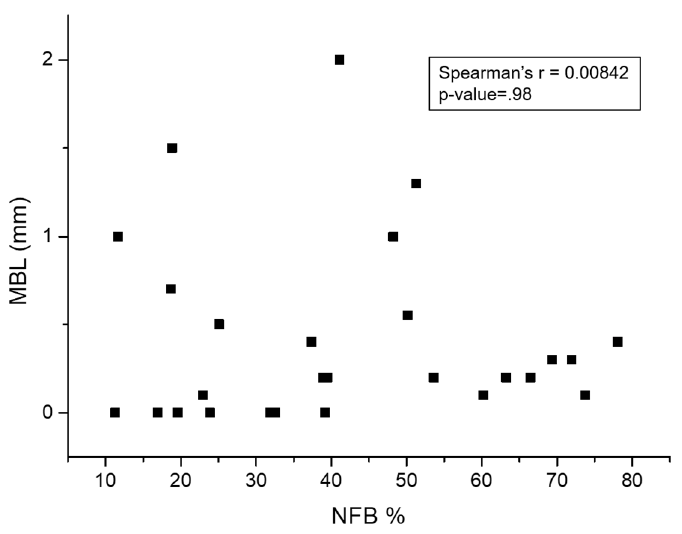
Figure 5. Regression analysis between Marginal Bone Loss (MBL, mm) and Newly Formed Bone (NFB, %).